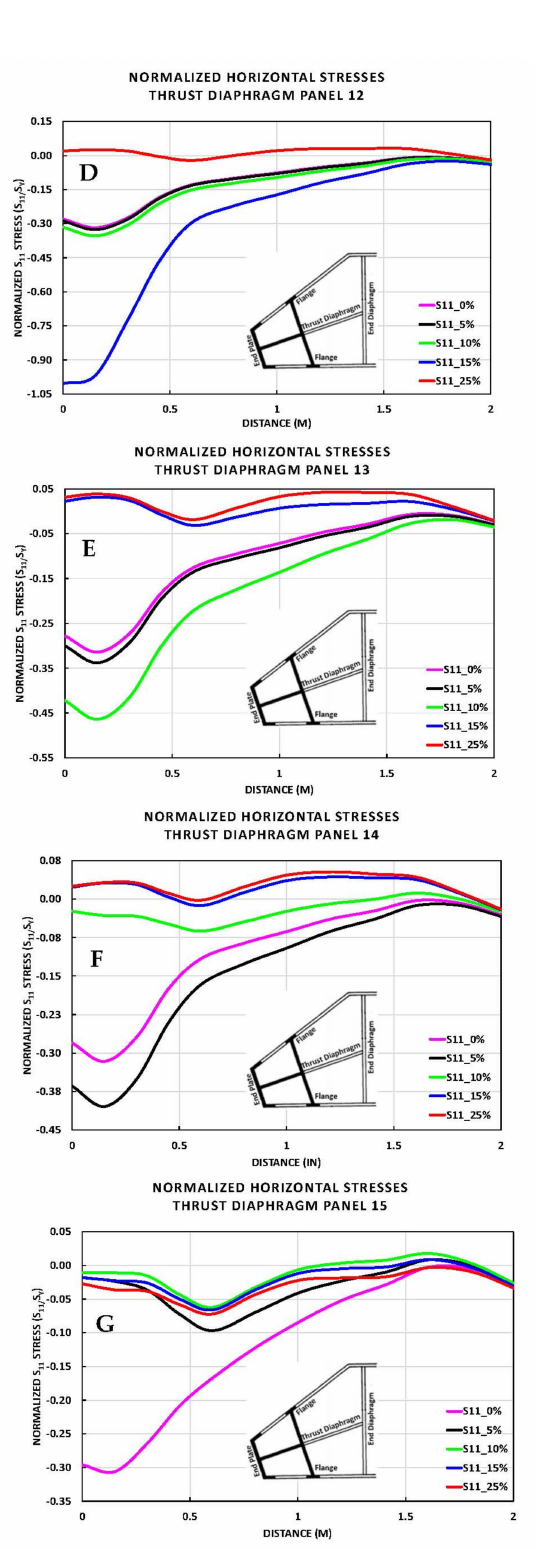
Figure 15. ( A – G ) Illustration of the horizontal stress captured along these